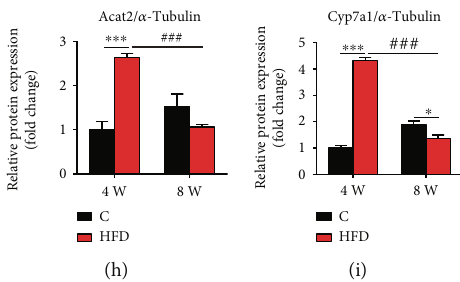
Figure 3: E ff ects of HFD on cholesterol and bile acid metabolism in the liver of Nile tilapia after 4-week and 8-week feeding trials. (a – e) mRNA expression of genes related to cholesterol synthesis (a), esteri fi cation (b), uptake (d), e ffl ux (e), and bile acid synthesis (c) in the liver ( n = 9 ); (f – i) relative expression of proteins related to cholesterol esteri fi cation (g, h) and bile acid synthesis (i) in the liver ( n = 4 ). Data are represented as means ± SD ; asterisks indicate the di ff erences between the C and HFD groups in the same feeding trial, ∗ P < 0 : 05 , ∗∗ P < 0 : 01 , ∗∗∗ P < 0 : 001 ; hash symbols indicate the di ff erences between 4-week and 8-week feeding trials of the same lipid level diet, # P < 0 : 05 , ## P < 0 : 01 , ### P < 0 : 001 ; C: control diet; HFD: high-fat diet. hmgcr : 3-hydroxy-3-methylglutaryl-coenzyme A reductase; sqle : squalene monooxygenase; lss : lanosterol synthase; msmo1 : methylsterol monooxygenase 1; acat1 : acetyl-CoA acetyltransferase 1; acat2 : acetyl-CoA acetyltransferase 2; cyp7a1 : cholesterol 7alpha-hydroxylase; ldlr : low-density lipoprotein receptor; abca1 : ATP binding cassette subfamily A member 1; abcg1 : ATP binding cassette subfamily G member 1; abcg5 : ATP binding cassette subfamily G member 5; abcg8 : ATP binding cassette subfamily G member